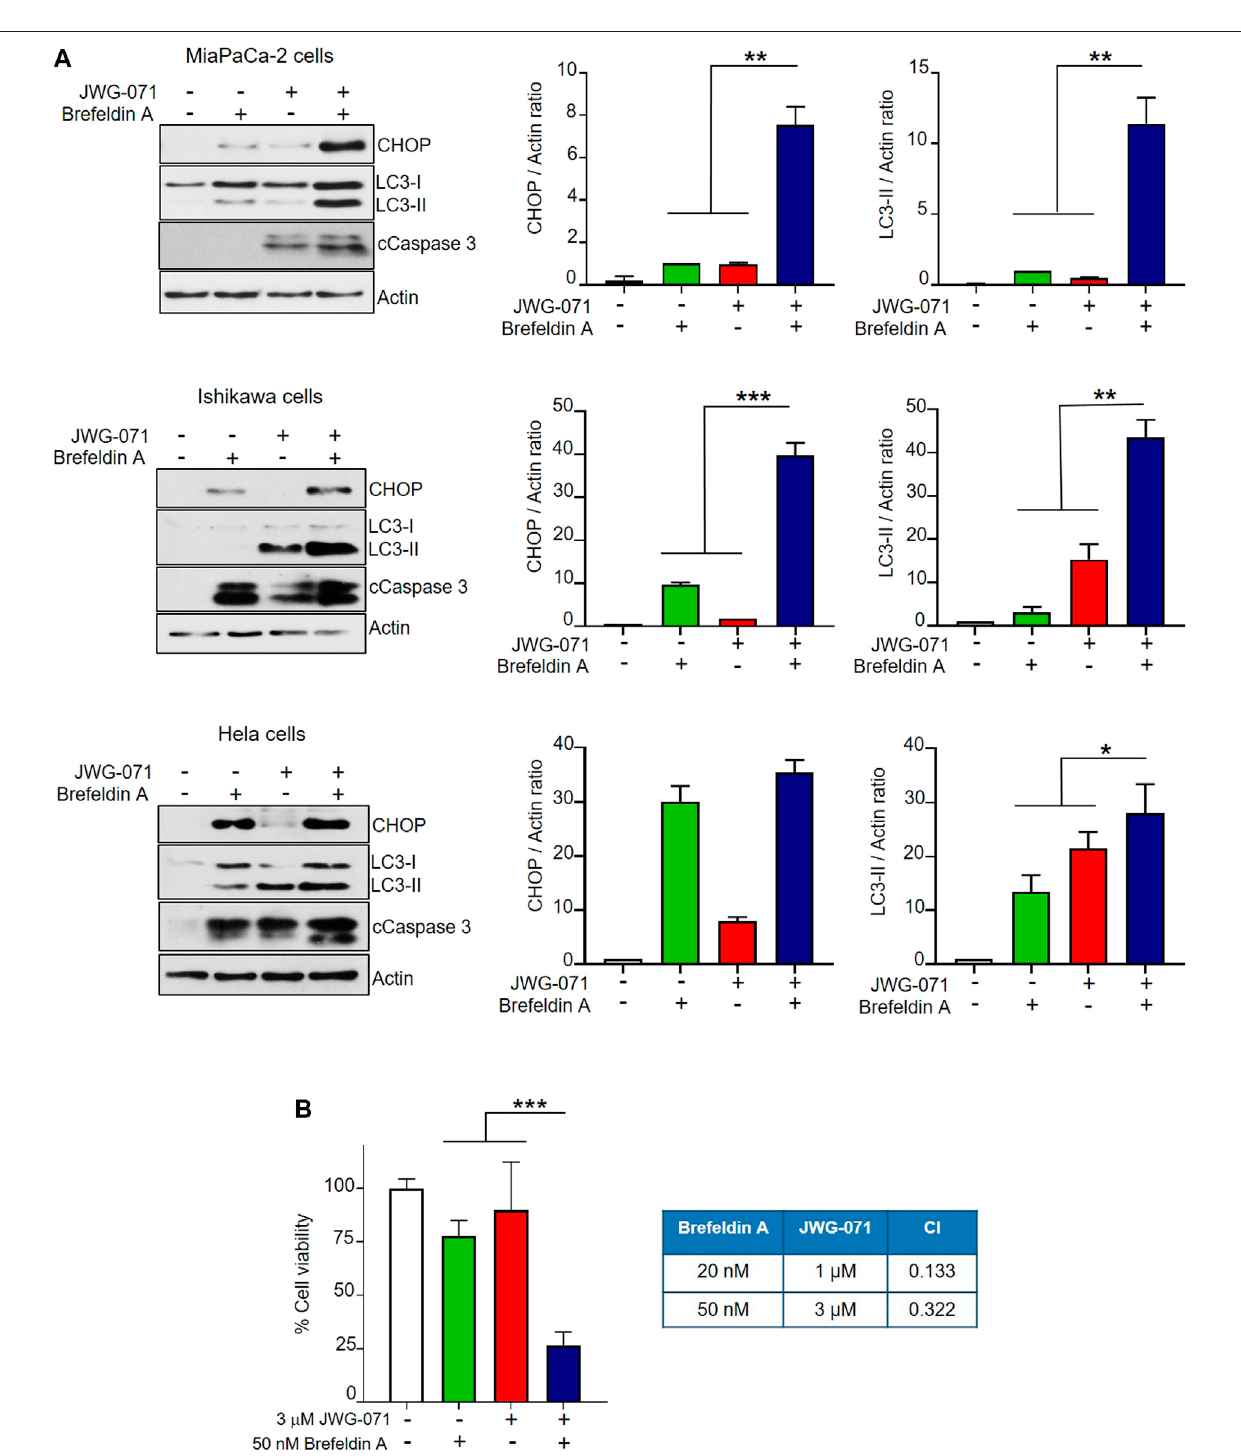
FIGURE6| ERK5inhibitioncooperateswiththeERstressinducerbrefeldinAtoactivateUPR,autophagyandcytotoxicity. (A) Cellsweretreatedfor24 hwith5 μ M JWG-071 and/or 400 nM brefeldin A. Levels of the indicated proteins were determined by immunoblot analysis. cCaspase-3, cleaved caspase-3. Right histograms showthequanti fi cationofCHOPandLC3-IIlevels,relativetoactin,asestimatedbydensitometry.Valuesrepresentmean ± SDoftwodifferentdeterminations.* p < 0.05 ** p < 0.01, *** p < 0.001 from individual treatments with JWG-071 or brefeldin A. (B) ERK5i synergizes with brefeldin A to induce cytotoxicity. MTT assay of MiaPaCa-2 cells incubated during 24 h with JWG-071 and/or brefeldin A at the indicated concentrations. Right table show the combination index (CI) analysis for different concentrations of JWG-071 and brefeldin A, obtained using the Compusyn software (CI > 1, antagonism; CI (cid:1) 1, summary effect; CI < 1, synergism.